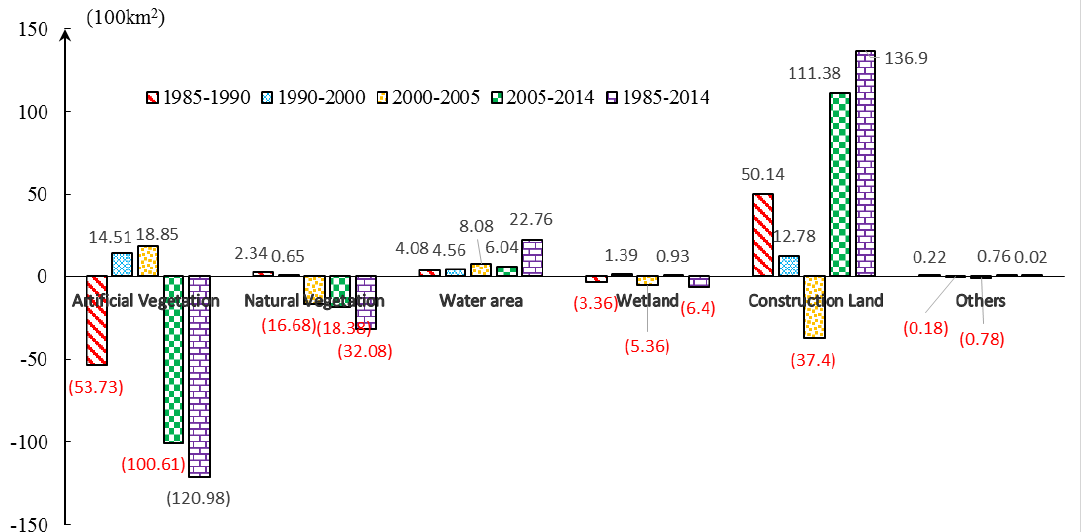
Figure 7. Land-use/land-cover transformations from 1985 to 2014. Table 3. Land-use/land-cover dynamics of the Huai River Basin from 1985 to 2014 (%). Land-Use/Cover Type